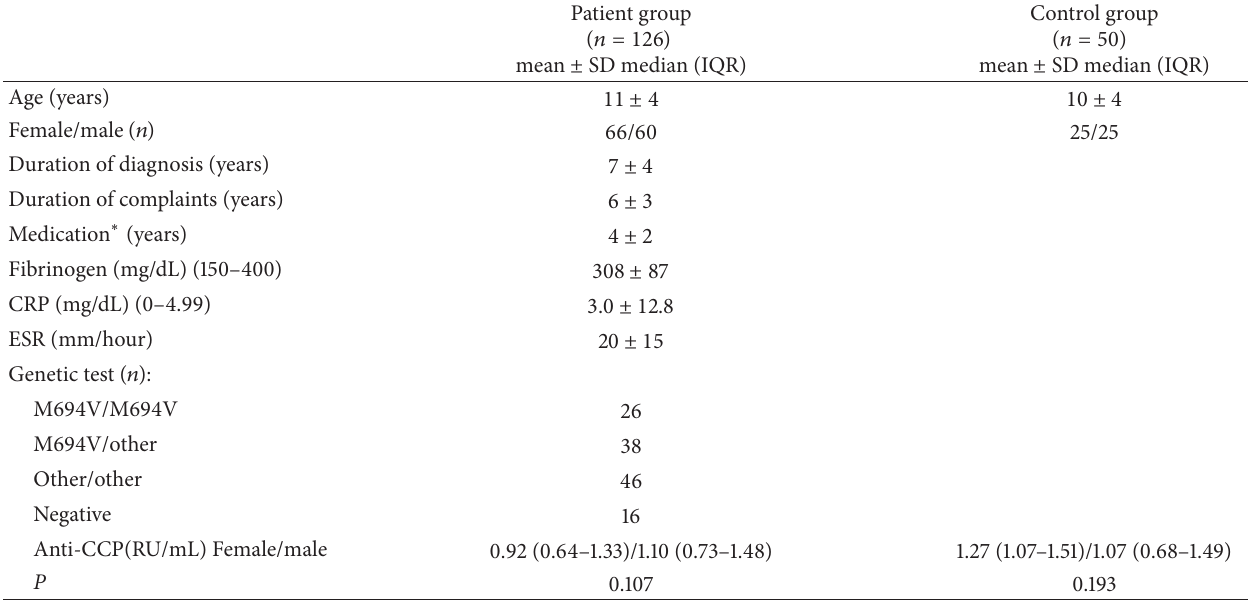
Table 1: Demographic characteristics and laboratory parameters, anti-CCP levels according to